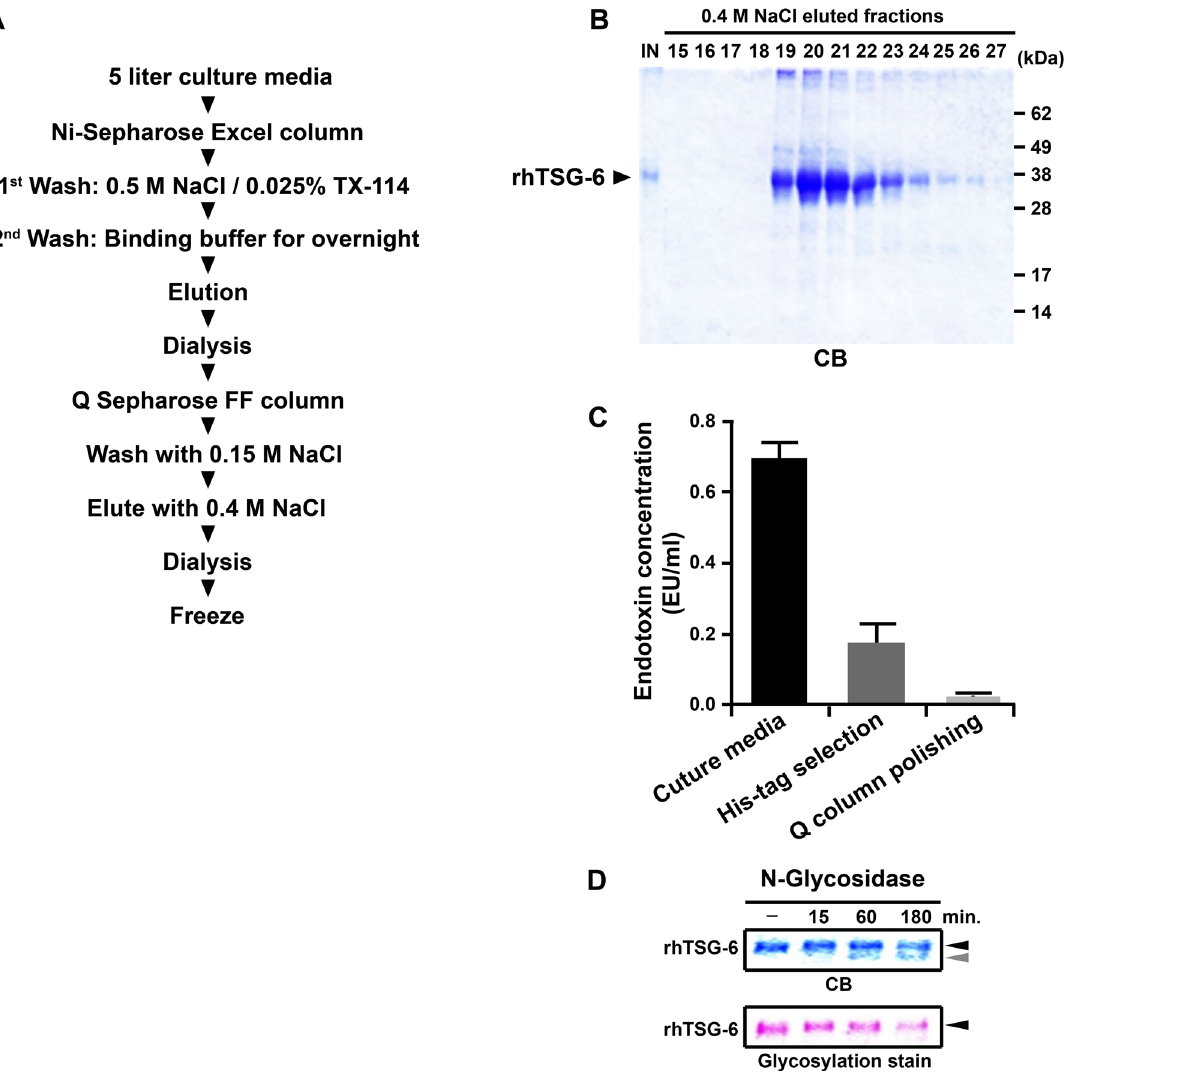
Fig 4. Purification of rhTSG-6 from 5 or 6 liters cultured media of the bioreactor. (A) Schematic for the purification steps. (B) Assay by SDS-PAGE of rhTSG-6 eluted from the Q-Sepharose FF column. Symbols: IN, input sample; CB, Coomassie Blue staining of gel. (C) Endotoxin content of conditioned culture medium, eluate from the His-tag column and Q-Sepharose FF column. Values are mean ± S.D. of 3 replicates. (D) Deglycosylation of the purified rhTSG-6. Arrows indicate deglycosylated forms